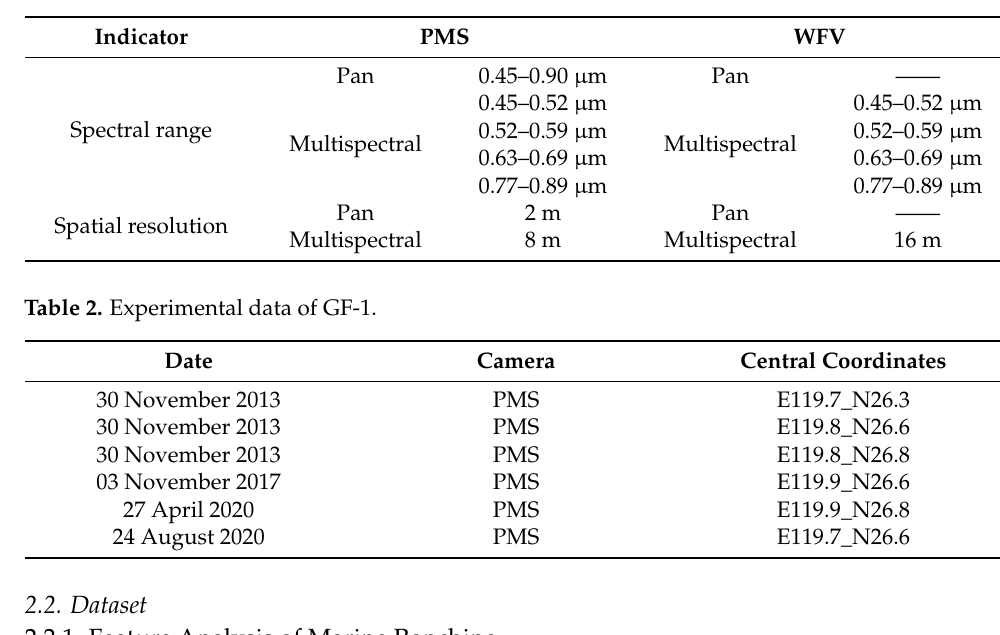
Figure 2. Experimental area (false color). Table 1. Technical indicators of Gaofen-1 (GF-1).